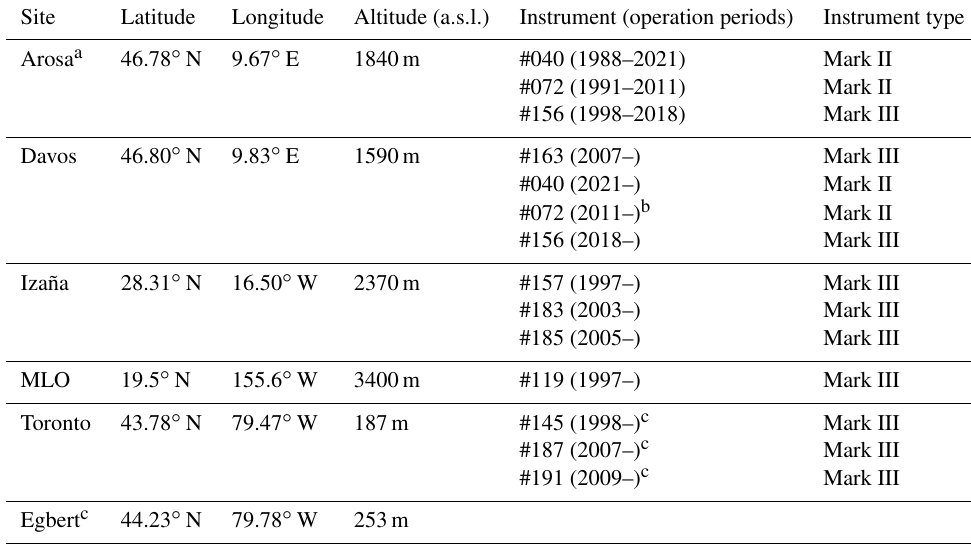
Table 1. Observation sites and instrument